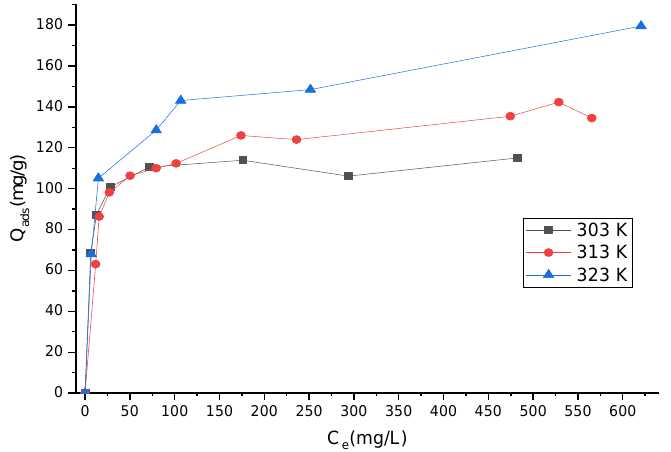
Figure 5. Adsorption isotherms of MB on OR-KOH/PEG-SG adsorbent as a function of temperature.